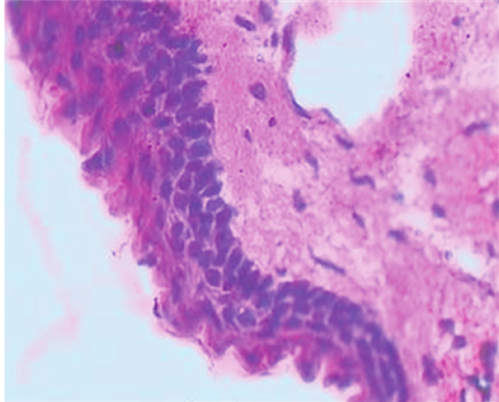
Figure 5: H&E stained section under 40X magnification shows 6–8 layers thick epithelial lining which is parakeratinized and corrugated.